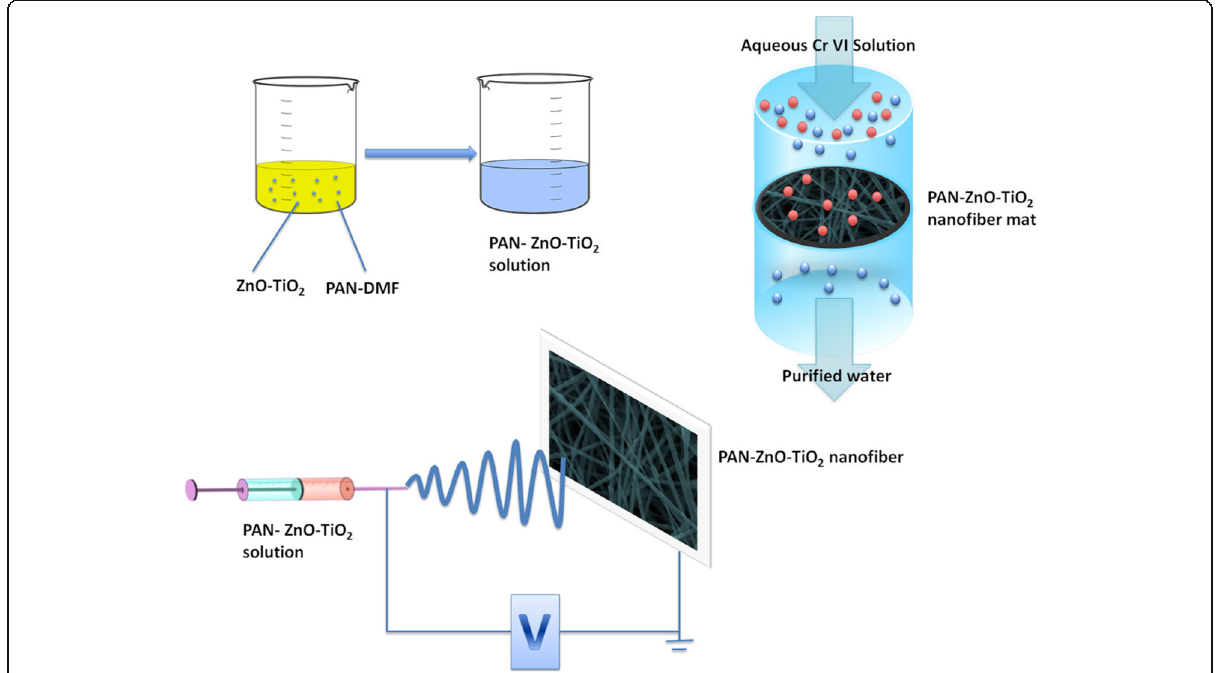
Fig. 2 The schematic of the fabrication of PAN n- fib@Mat decorated nanoparticle and the application for Cr (VI)